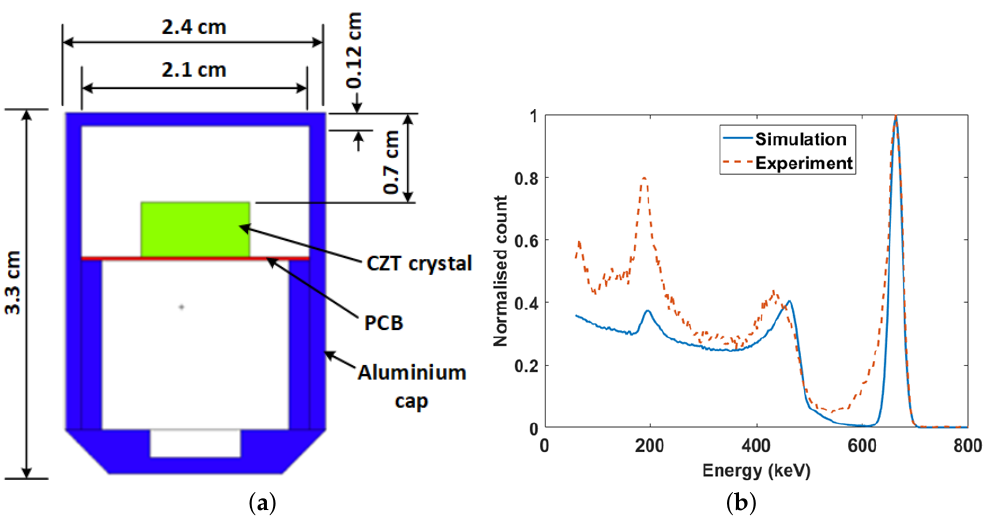
Figure 4. ( a ) MCNP5 model of the gamma detector. The crystal volume is 1 cm × 1 cm × 0.5 cm; ( b ) Experimental and simulated Cs-137 spectrum from the model and real detector.